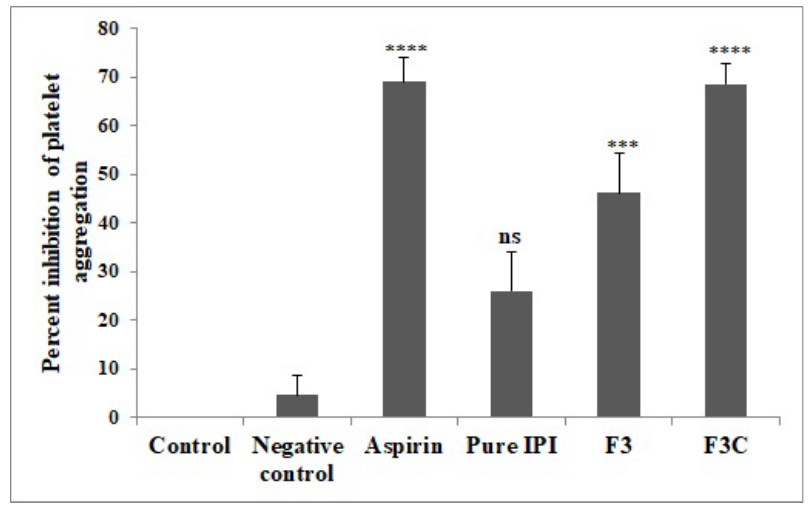
Figure 7. Effect of various treatments on percent inhibition of platelet aggregation. Results are expressed as Mean ± SEM ( n = 3), analysed by one-way ANOVA followed by Dunnett’s test of multiple comparison where ns = non-significant, **** p < 0.0001, *** p < 0.001, p < 0.05 where various treatment groups were compared with negative control group.